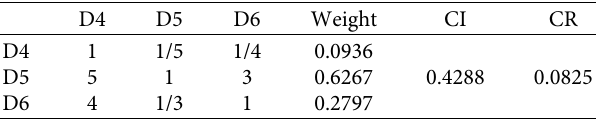
Table 4: Judgment matrix, weight allocation, and consistency test